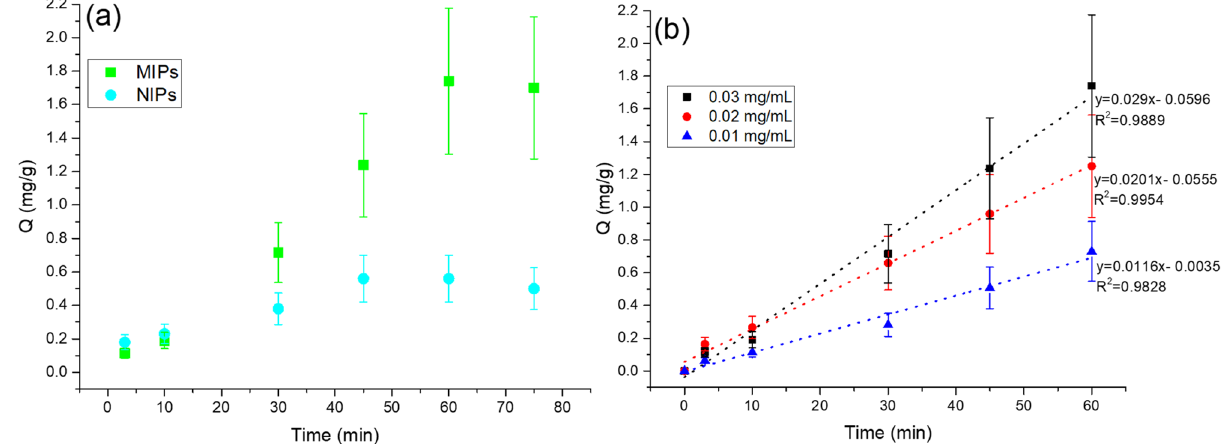
Figure 6. ( a ) Adsorption kinetics of MIP/NIP and ( b ) adsorption curves for analytes at different concentrations (10–30